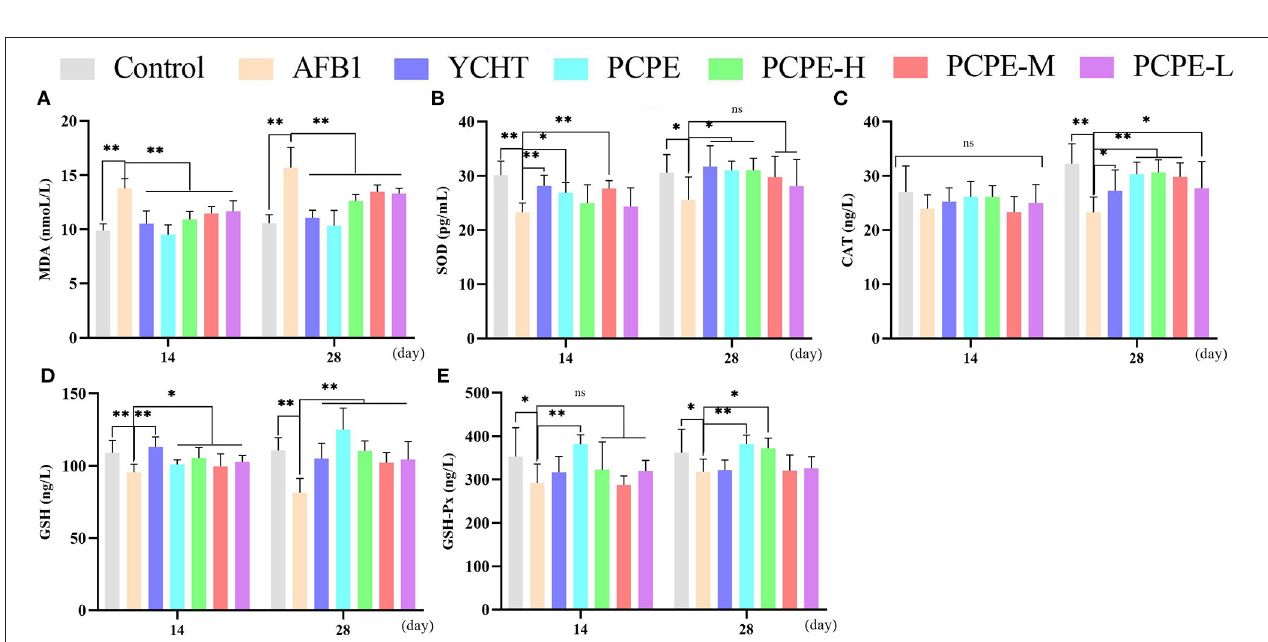
FIGURE 2 | Histopathological analysis of liver from different groups on day 14 and 28 in different groups of the experiment. (a) intrahepatic hemorrhages, (b) inflammatory cells infiltration and fatty degenerations, (c) bile duct hyperplasia.